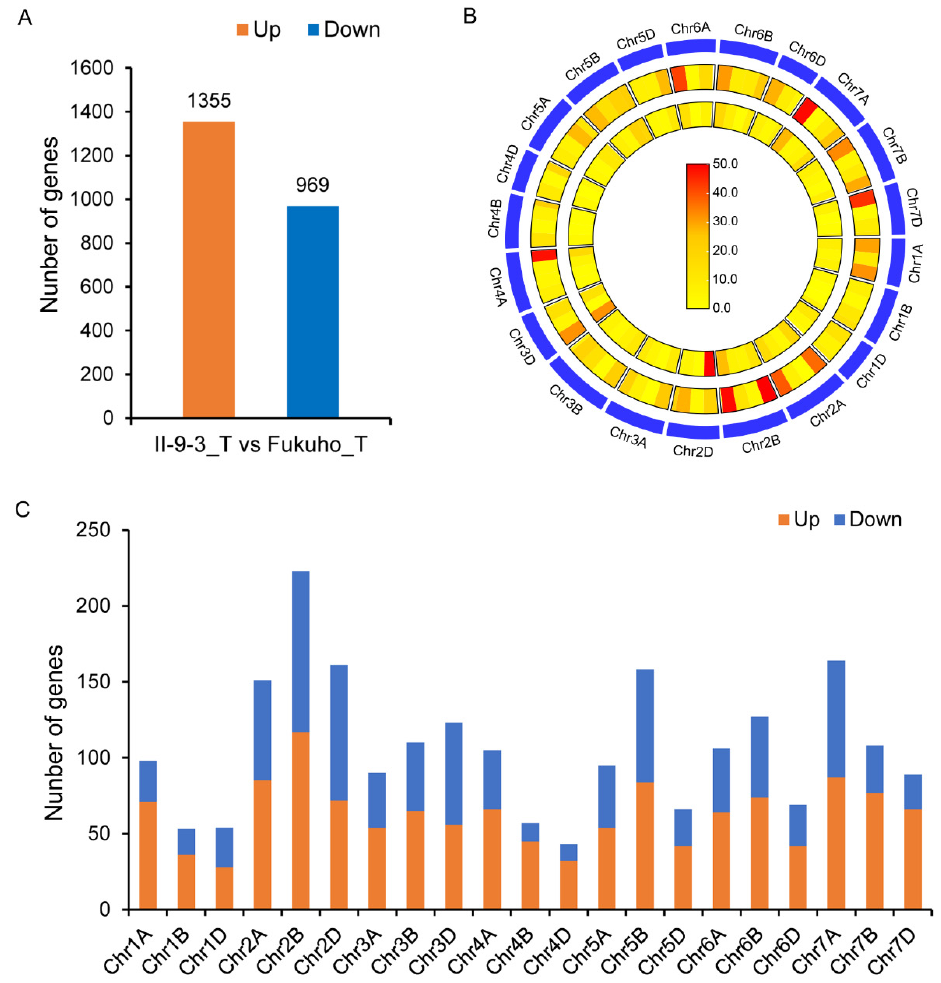
Figure 8. Wheat DEGs of II-9-3_T vs. Fukuho_T: ( A ) number of wheat DEGs of the addition line II-9-3; ( B ) heatmap of the gene density distribution of wheat DEGs. The inner circle represents the downregulated genes, and the outer circle represents the upregulated genes; ( C ) distribution of DEGs across the 21 wheat